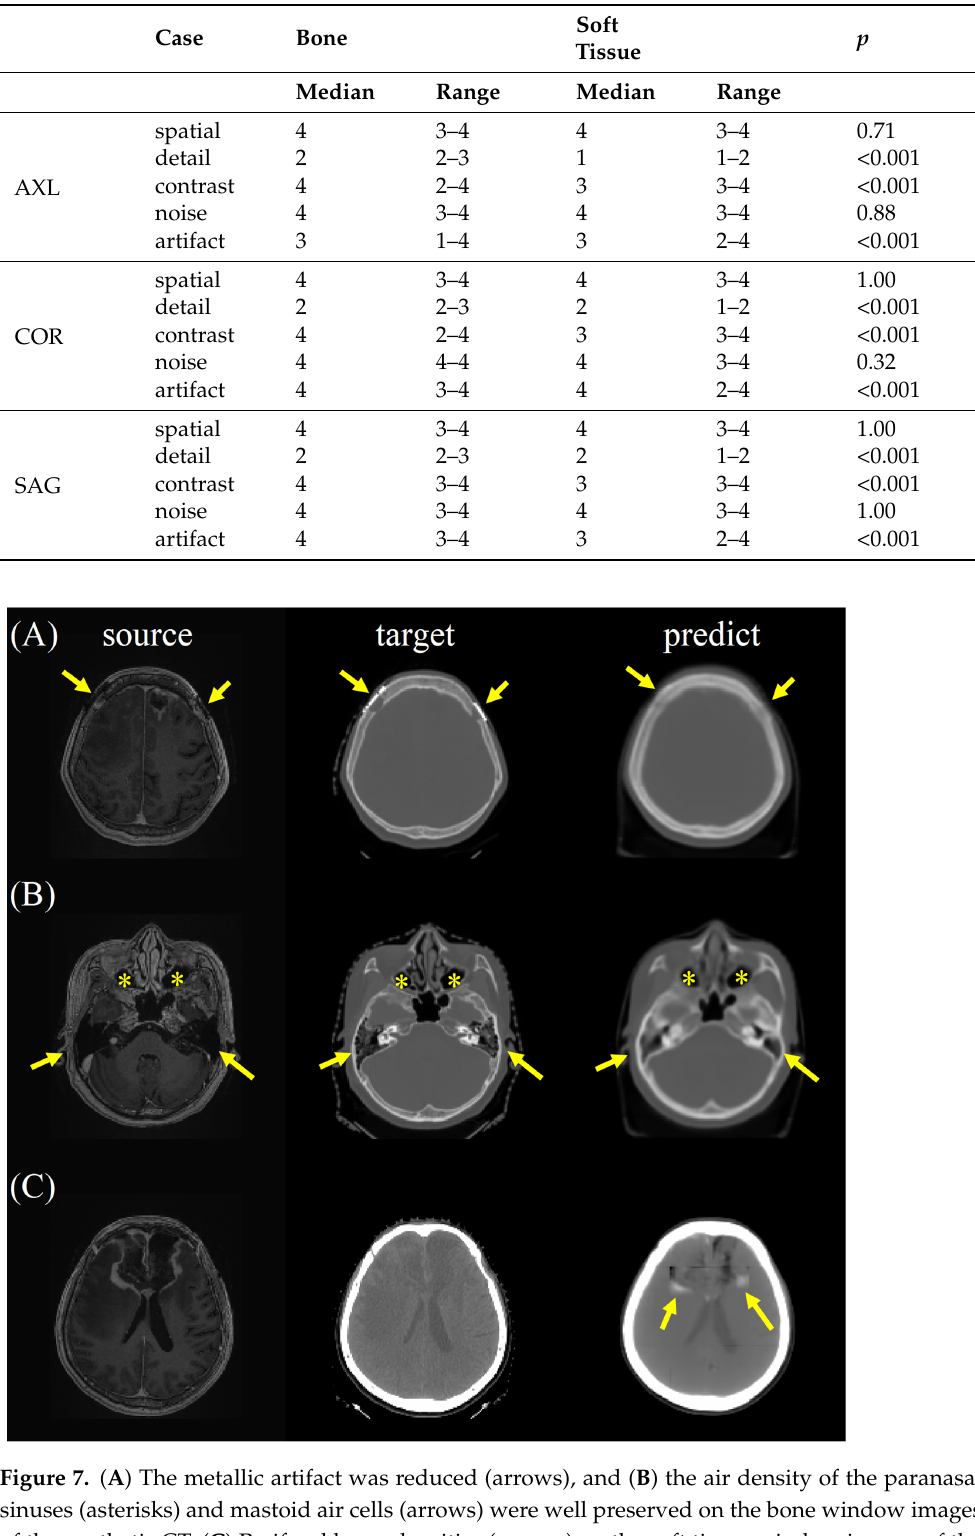
Table 1. Clinical satisfaction score based on the bone and soft tissue window synthetic CT.